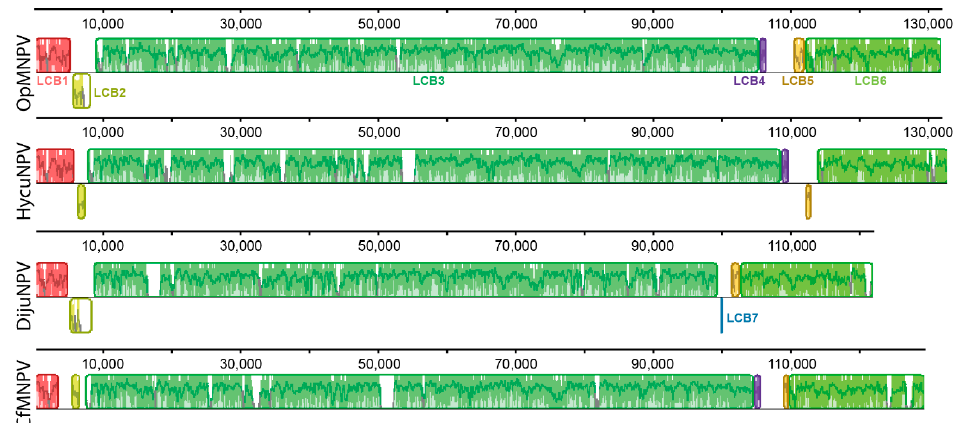
Figure 3. Genome comparison of DijuNPV and its related viruses. DijuNPV is compared to three alphabaculovirus genomes, including Hyphantria cunea nucleopolyhedrovirus (HycuNPV), Orgyia pseudotsugata multiple nucleopolyhedrovirus (OpMNPV), and Choristoneura fumiferana multiple nucleopolyhedrovirus (CfMNPV). The same colors depict the same LCBs across the genomes. Seven Locally Collinear Blocks (LCB) numbered from 1 to 7 were found. The DijuNPV genome lost LCB4 (purple) and present LCB7 (blue) instead. The white regions depict sequence loss.